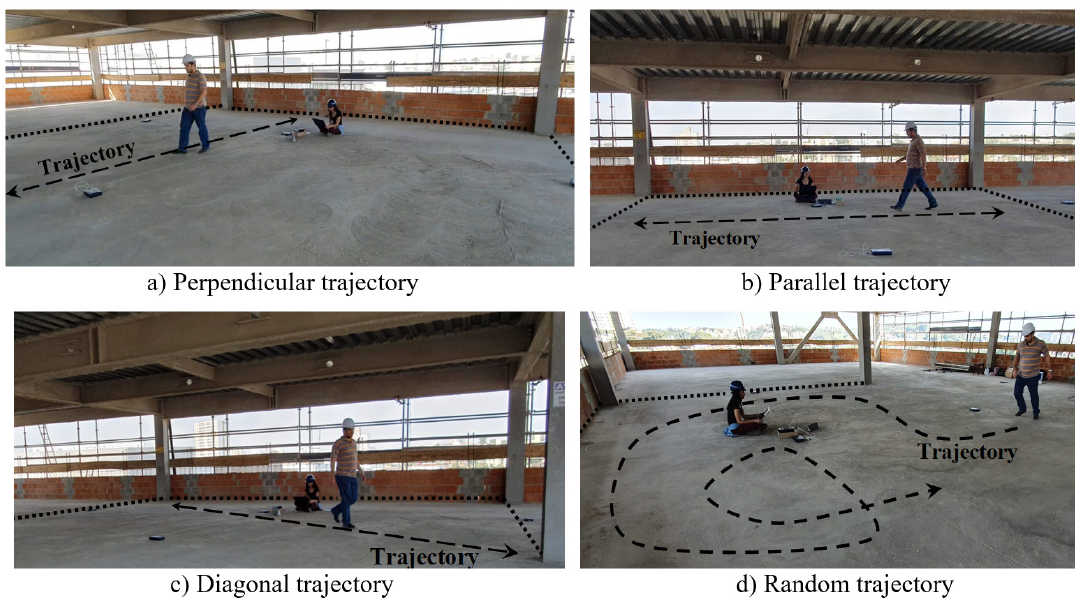
Figure 6. Walking paths illustration.